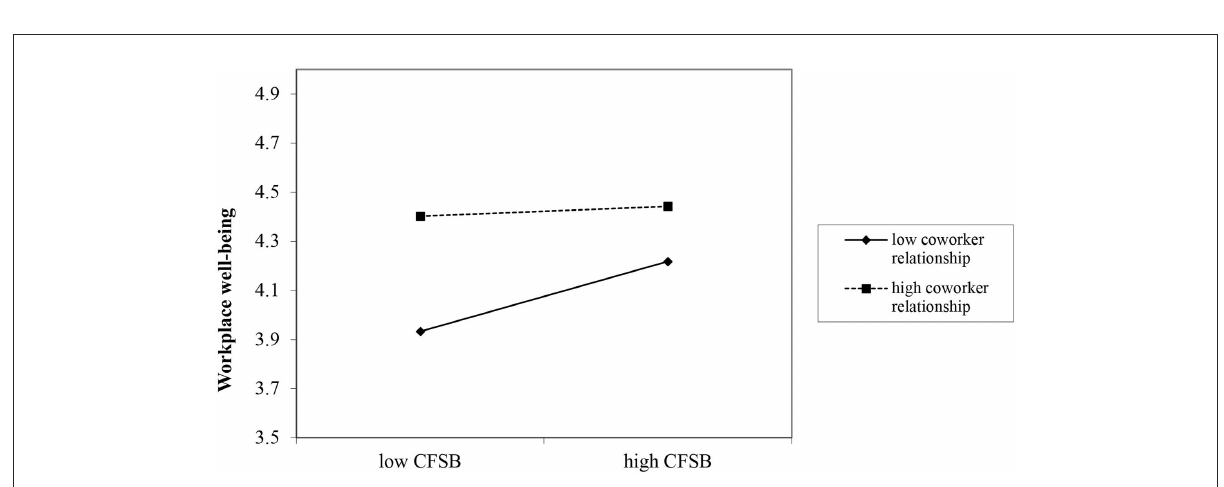
FIGURE3 The moderating role of coworker relationship on the coworker feedback-seeking behavior (CFSB) and workplace well-being